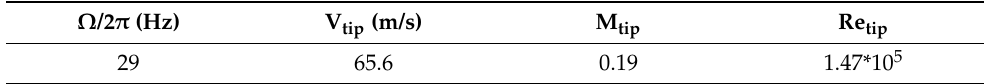
Table 2. Parameter of the measured test case.